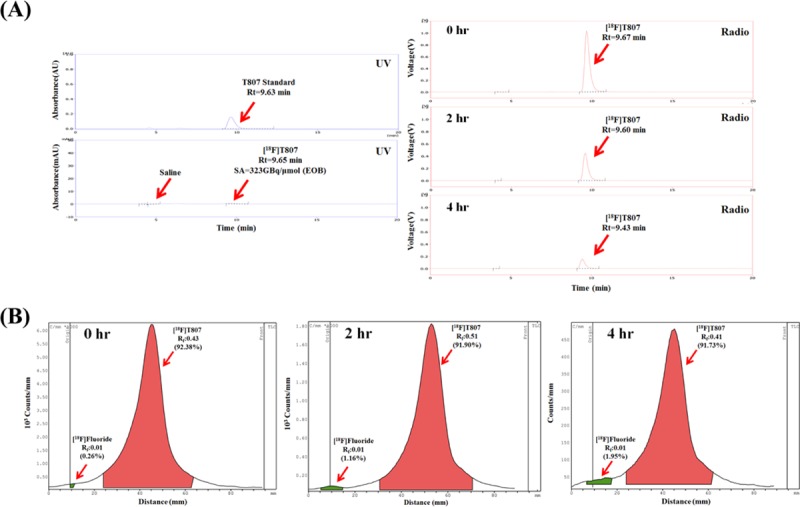
Representative analytical radio-HPLC (A) and radio-TLC chromatograms (B) of [18F]T807 at 0, 2 and 4 hrs after EOS.